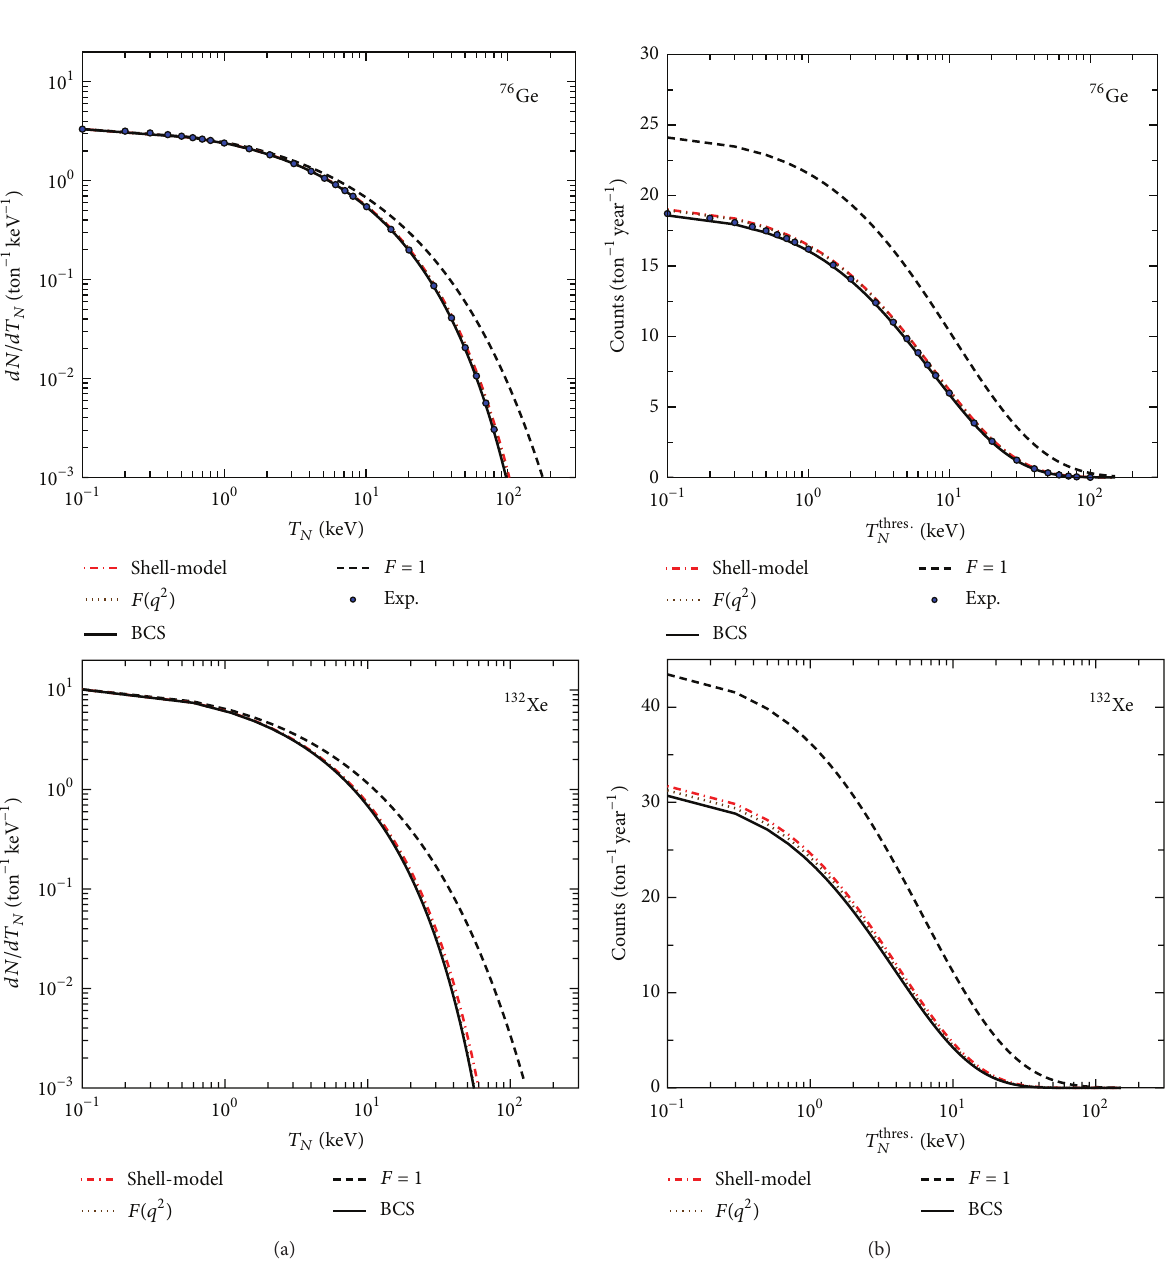
Figure 6: Same as Figure 5 but for 76 Ge and 132